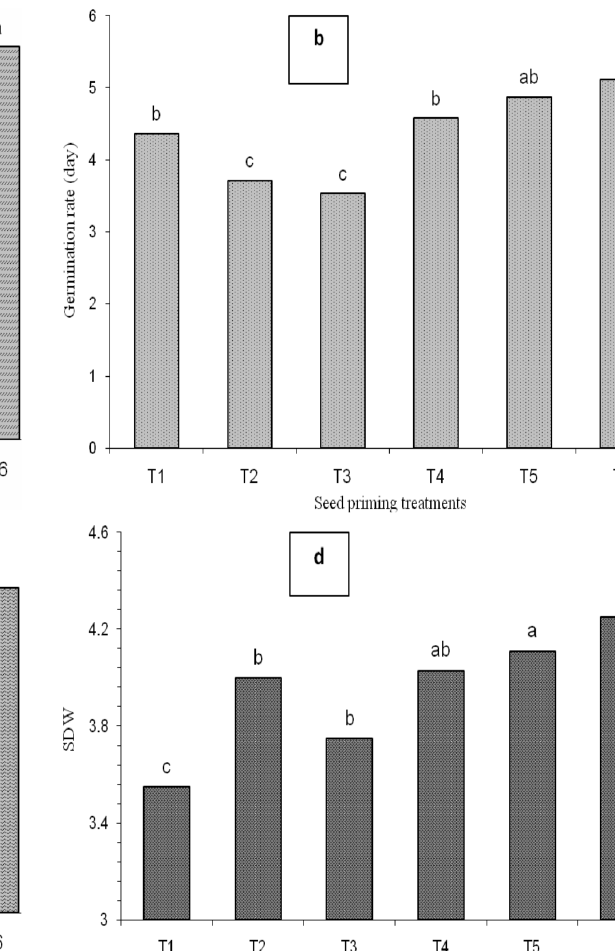
: non-primed; T , T : Salt priming of NaCl and KNO 1 2 3